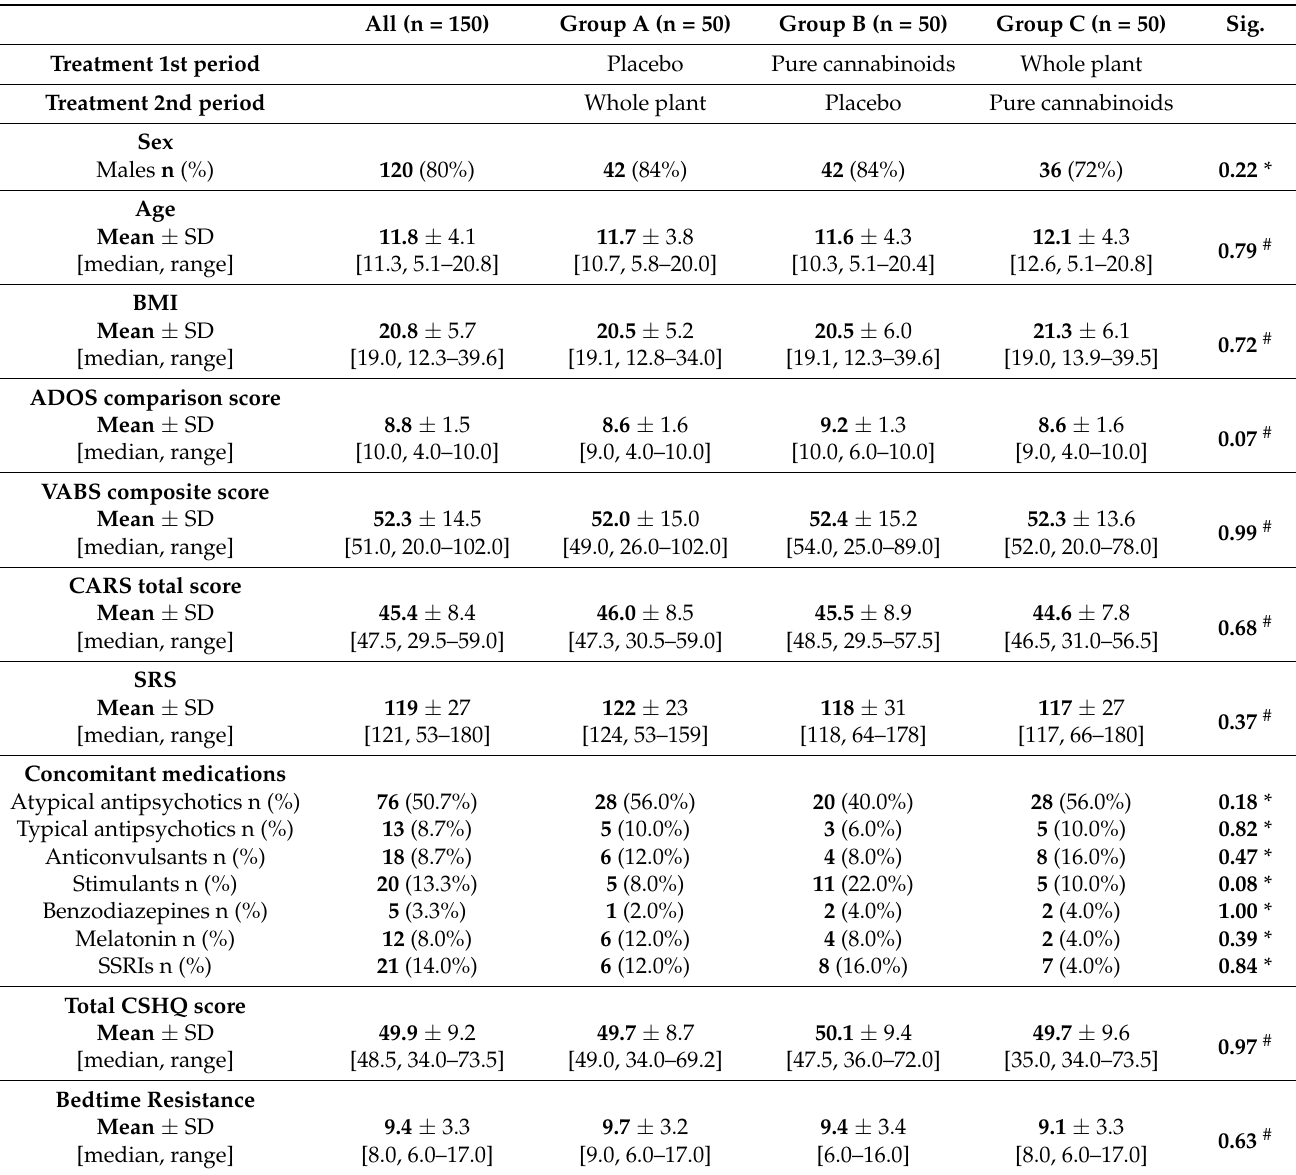
Table 1. Participants’ baseline